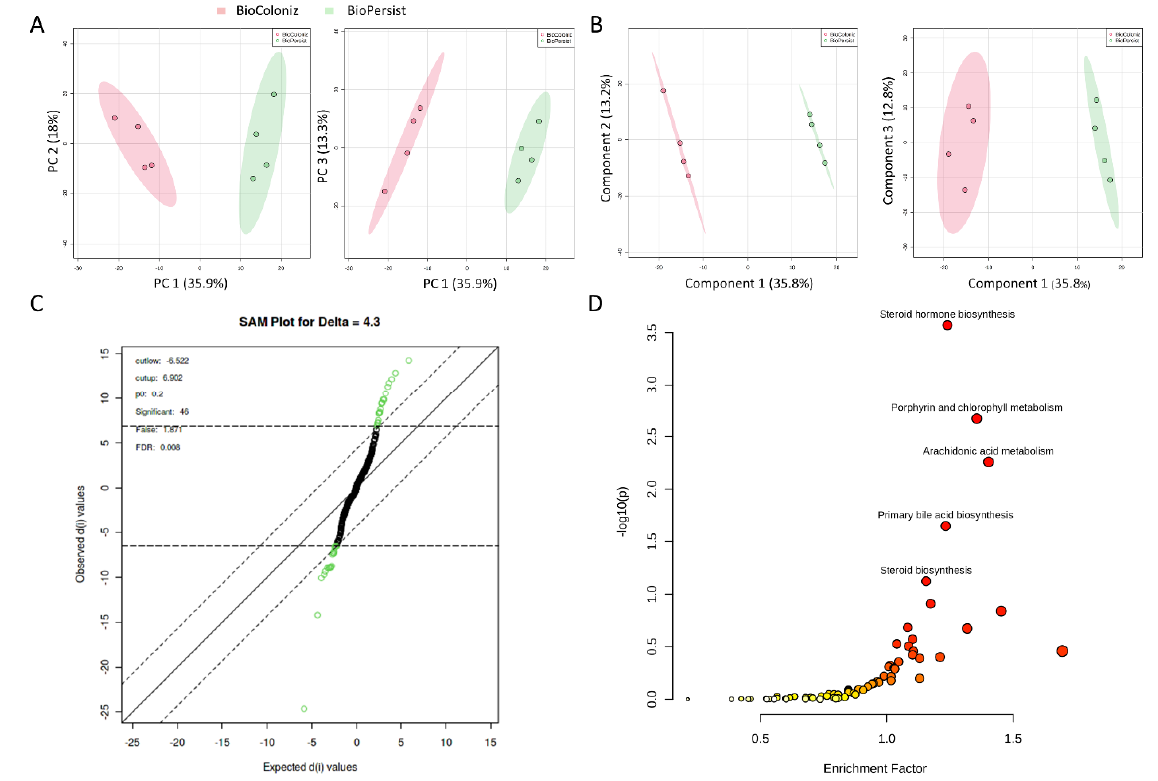
Figure 5. Signature pathways in mice treated with BioColoniz and BioPersist. ( A ) PCA score plots with PC1 against PC2 and PC1 against PC3 for mice treated with BioColoniz and BioPersist. ( B ) PLS-DA score plots with PC1 against PC2 and PC1 against PC3 for mice treated with BioColoniz and BioPersist. ( C ) Significant pathways annotated with the mouse KEGG database. n = 4 per group. ( D ) Significance analysis of microarray (SAM) analysis identified 46 significant features of the two probiotics. Table 3. Significant pathways hit with 793 unique KEGG IDs.